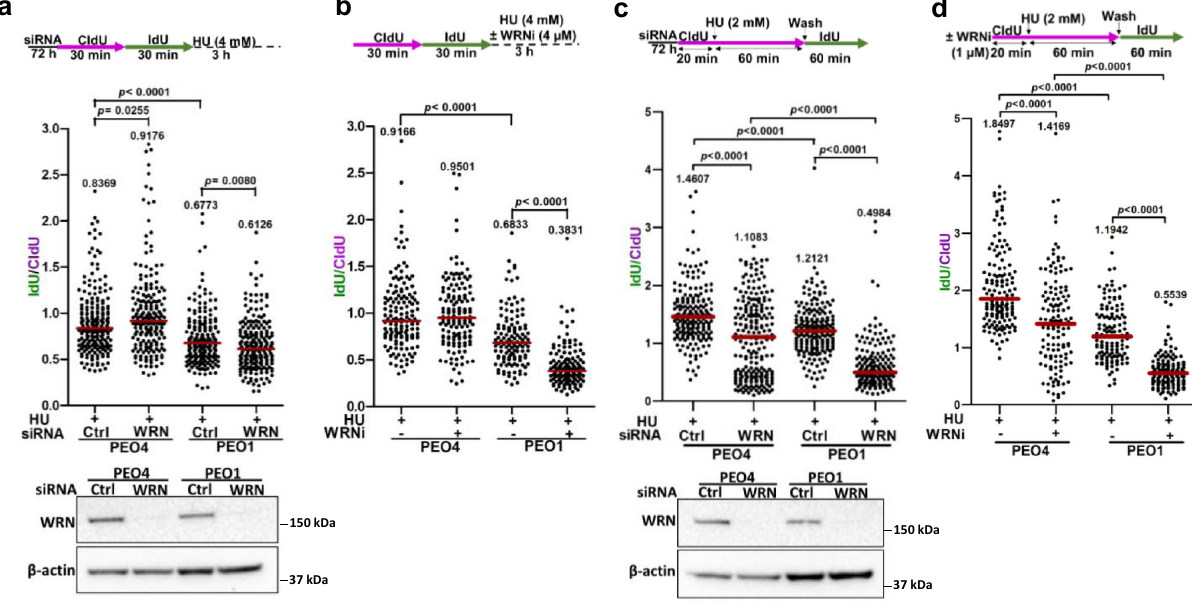
Fig. 2 WRN helicase inhibition causes increased fork degradation and replication restart defects in BRCA2 -mutated cancer cells. a (Upper panel) Schematic of the fork stability assay performed in PEO1 and PEO4 cells upon WRN knockdown. (Lower panel) Scatter dot plot showing quanti fi cation of IdU/CldU ratios in individual experimental conditions. Representative of n = 3 independent experiments; p -values ( p = 0.0255, p < 0.0001, p = 0.0080) were derived from n ≥ 200 DNA fi bers using two-tailed Mann – Whitney test. Knockdown of WRN was veri fi ed by immunoblotting. b (Upper panel) Schematic of the fork degradation experiment in PEO1 and PEO4 cells upon WRNi treatment. (Lower panel) Graphical quanti fi cation of the results obtained from the fork stability experiments as described above. Representative of n = 2 indepe n dent experiments; p -values ( p < 0.0001, p < 0.0001) were derived from n ≥ 125 DNA fi bers using two-tailed Mann – Whitney test. c (Upper panel) Scheme of the fork restart assay performed in PEO1 and PEO4 cells upon siRNA-mediated knockdown of WRN. (Lower panel) Scatter plot showing IdU/CldU ratios in individual experimental conditions. Representative of n = 2 independent experiments; p -values ( p < 0.0001, p < 0.0001, p < 0.0001, p < 0.0001) were derived from n ≥ 195 DNA fi bers using two-tailed Mann – Whitney test. Immunoblots showing relative knockdown levels of WRN as assessed 72 h post-transfection. d , (Upper panel) Schematic of the fork restart assay in HU-treated PEO1 and PEO4 cells upon WRN helicase inhibition. (Lower panel) Scatter plot showing IdU/CldU tract length ratios in individual experimental conditions. Representative of n = 2 independent experiments; p -values ( p < 0.0001, p < 0.0001, p < 0.0001, p < 0.0001) were derived from n ≥ 125 DNA fi bers using two-tailed Mann – Whitney test. Horizontal red bars in scatter plots indicate the median of IdU/CldU ratios; median IdU/CldU values are indicated; purple and green colors indicate CldU and IdU labeling, respectively; data points within the speci fi ed axis limits are shown. β -actin was used as a loading control in immunoblots in ( a ) and ( c ). Western blots a , c were repeated independently at least two times with similar results. Source data are provided as a Source Data fi